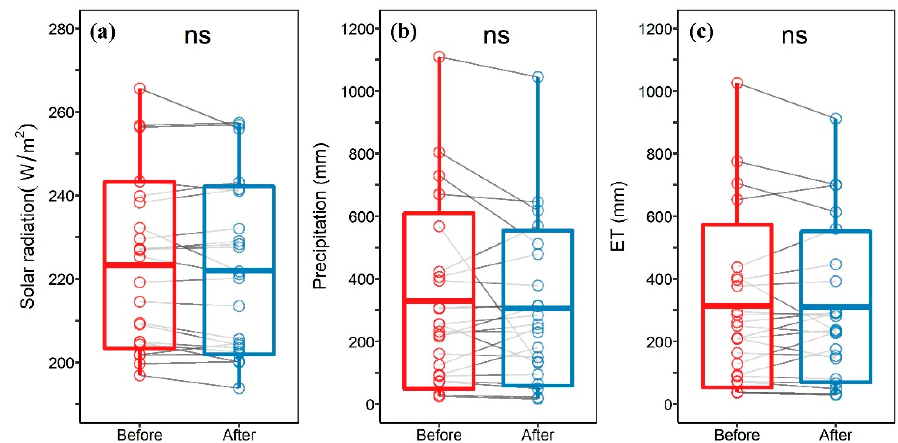
Figure 7. The ( a ) solar radiation, ( b ) precipitation, and ( c ) evapotranspiration (ET) are shown before (red part) and after (blue part) the installation of the PV powerplants using the high-resolution ERA reanalysis climate data. The gray line connected the paired points; ns, *, **, ***, and ****: statistically significant at p > 0.05, p < 0.05, p < 0.01, p < 0.001, and p < 0.0001